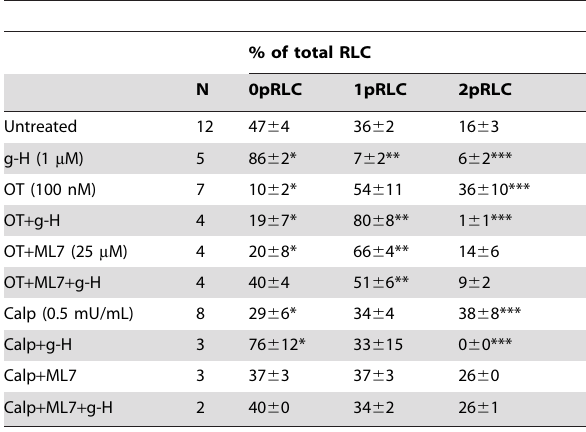
All data are shown as mean 6 SEM. *, **, and ***indicate significant differences (p , 0.05) compared to 0pRLC, 1pRLC and 2pRLC in the untreated group, respectively.